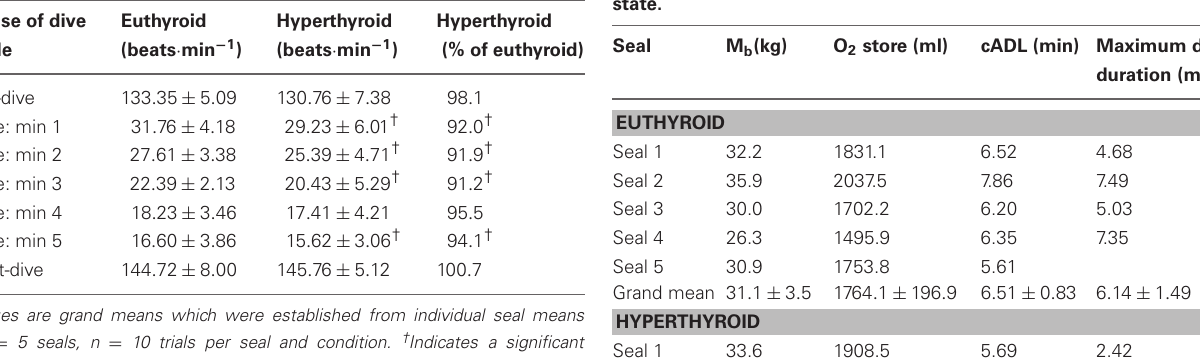
Table 2 | Heart rates before, during, and after submergence in the euthyroid and hyperthyroid state.